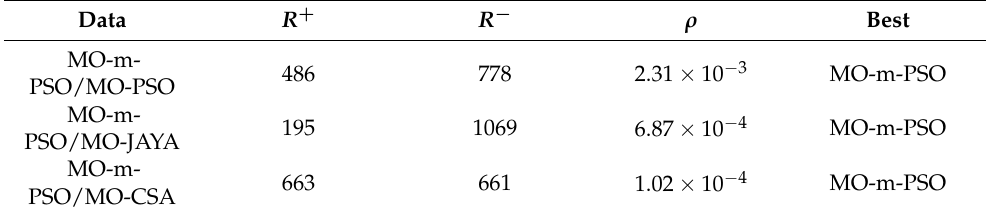
Table 6. Statistical results of MO-M-PSO for IK